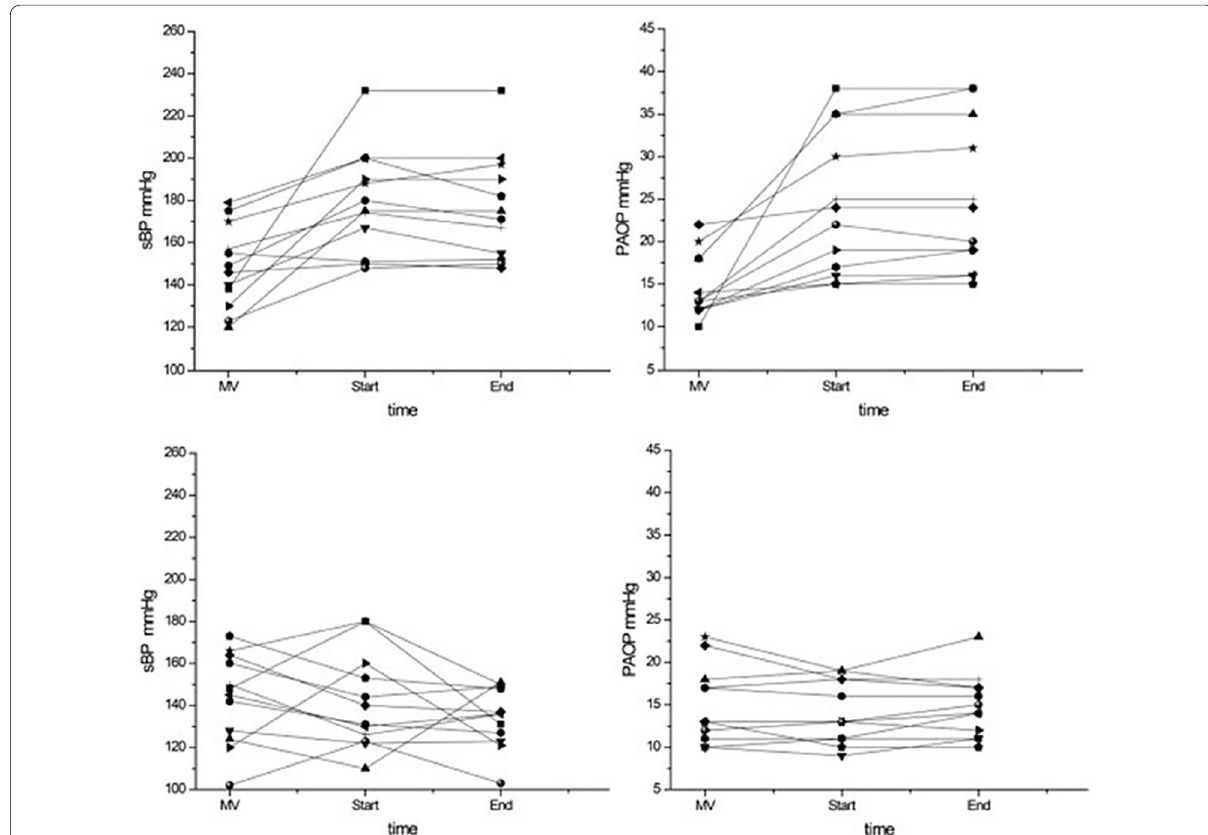
Fig. 4 Individual values of systolic blood pressure (sBP) (left) and pulmonary artery occlusion pressure (PAOP) (right) obtained on mechanical ventilation (MV) and at the 10th minute (Start) and the last minute (End) of a spontaneous breathing trial without (upper panel) and with nitroglycerin treatment (lower panel) (adapted from